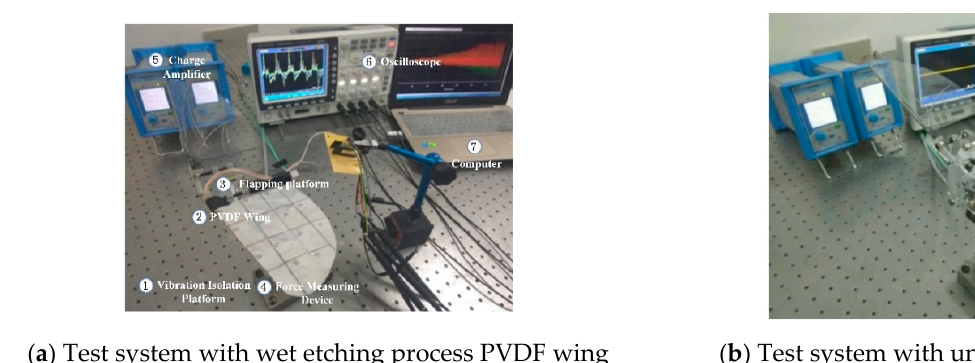
Figure 4. Photograph of the test system.